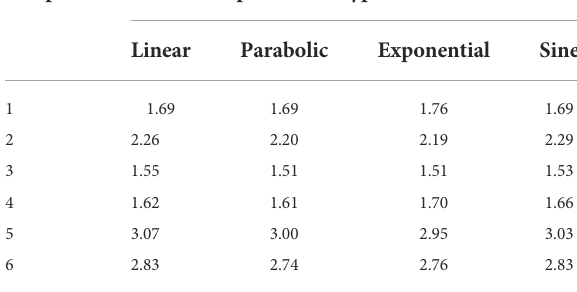
TABLE 7 Quantitative scoring of individual sample about tunnel squeezing ( GP I ).